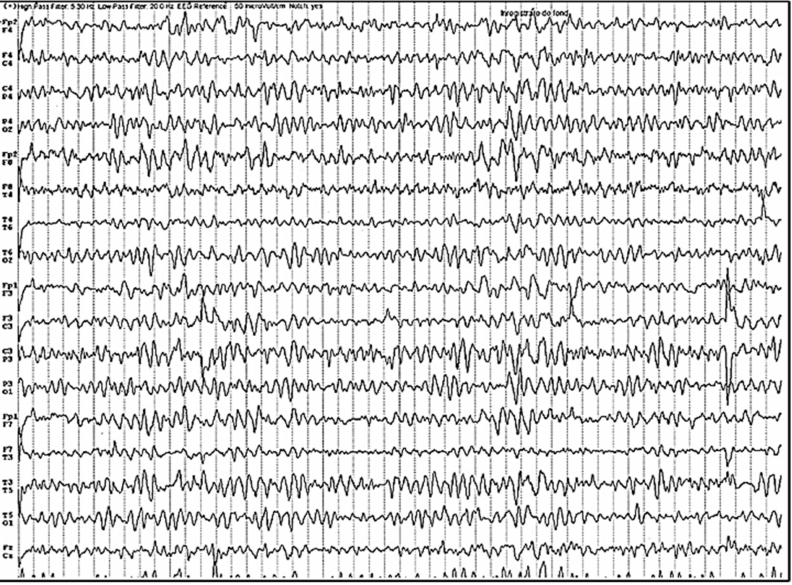
Figure 3. EEG examination revealing bilateral, slow-wave discharges, and spikes on the frontal, parietal and temporal